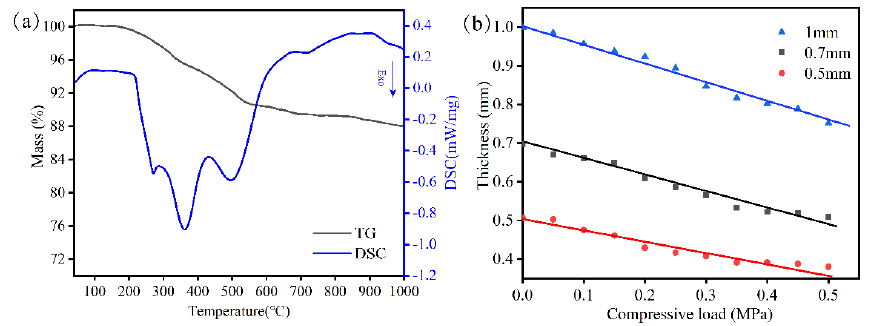
Figure 1. TG-DSC curves of vermiculite at a heating rate of 10 °C/min ( a ); function of thickness and compressive load ( b ).